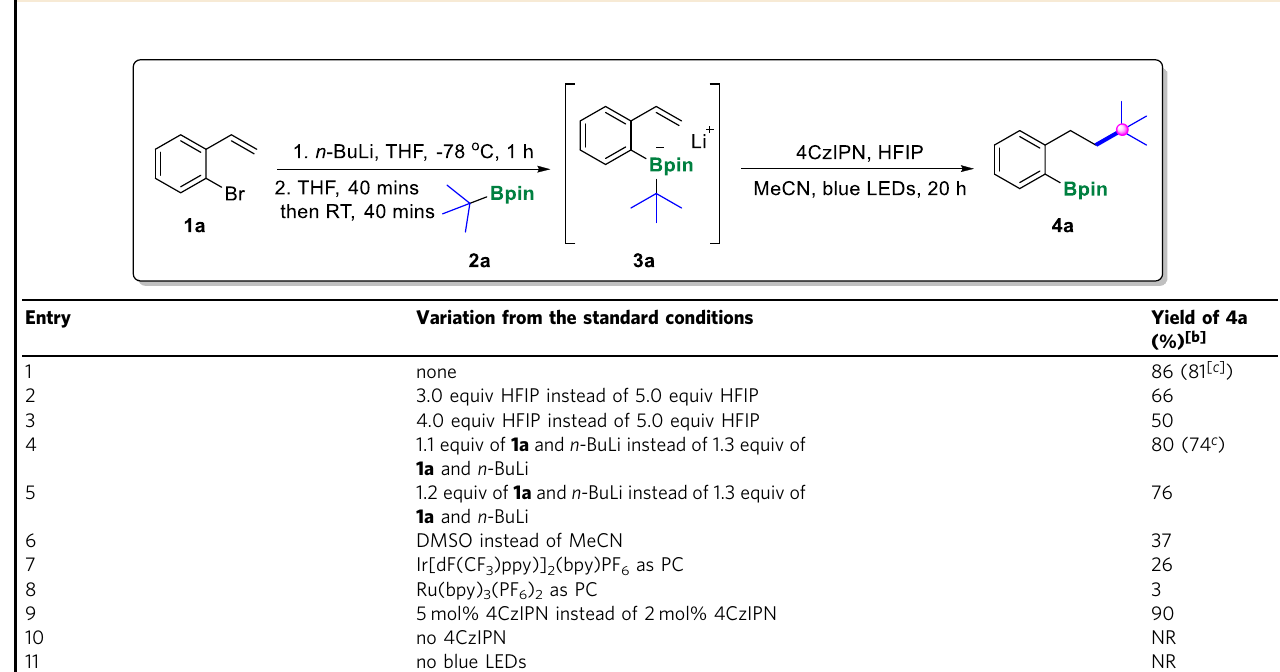
Table 1 Optimization of the reaction conditions [a]